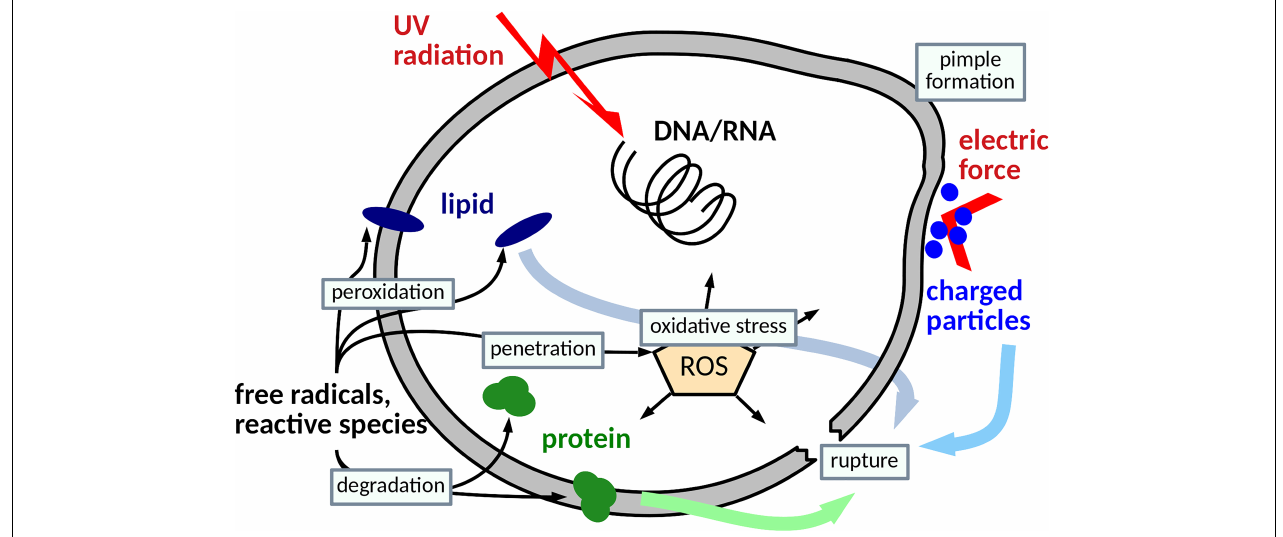
FIGURE 1 | Possible mechanisms of microbial inactivation by non-thermal plasma